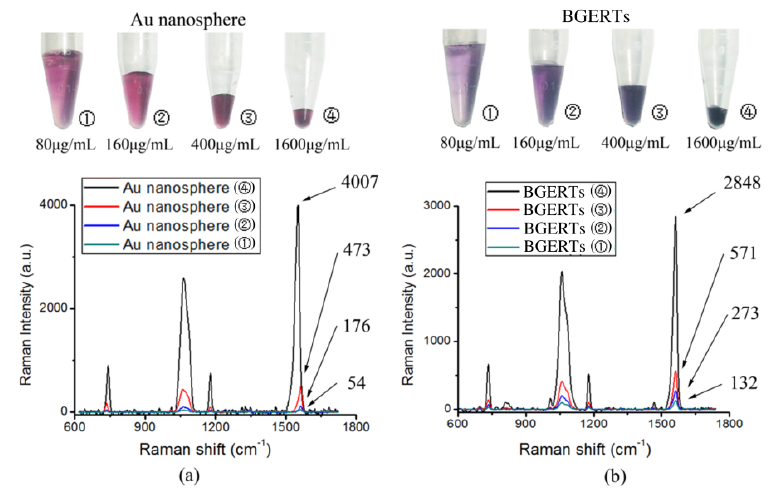
Figure 7. The influence of the nanomaterial concentration on the SERS signal intensity ( a ) Au nanospheres, ( b ) BGERTs.